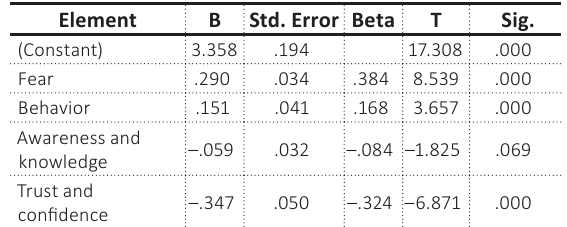
Table 8. Coefficients for